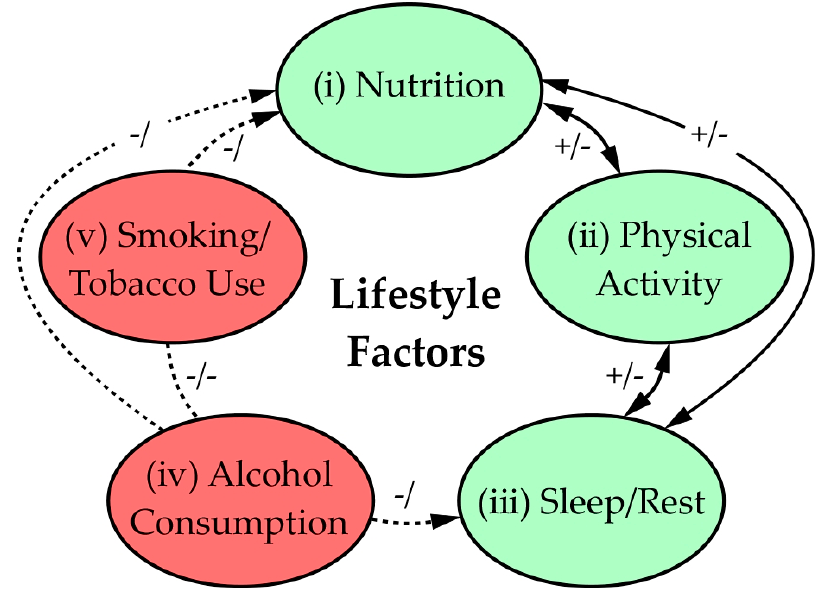
Figure 2. Lifestyle factors that affect clinical health outcomes in COVD-19 infections. Dashed lines indicate negative effects, whereas solid lines connect factors known to improve health outcomes; arrows denote interaction direction(s). Red indicates negative lifestyle factors; green indicates positive factors. (i) Nutrition is essential in supporting immune system function and is affected by other factors positively/negatively (+/ − ) [129]. Poor quality rest or lack of physical activity can limit the benefit of nutrition as a health factor ( − ), and the inverse is true (+). (ii) Physical activity and regular exercise help mitigate disease effects and are related to nutrition and rest similarly [130]. (iii) Quality sleep and rest contribute to healthy outcomes, and affect and are affected by nutrition and activity. Note that inadequate sleep can induce stress/anxiety that can exacerbate health outcomes ( − ). (iv) Alcohol consumption leads to organ stress and dysfunction, depresses the immune system response to viral and bacterial infections, and negatively impacts sleep quality ( − /) [131]. (v) Tobacco use has well-known detrimental effects on the immune system and leads to many clinical health problems that exacerbate infectious disease outcomes ( − /) [132]. Smoking and alcohol consumption are often correlated and thus have negative interactions ( − / −